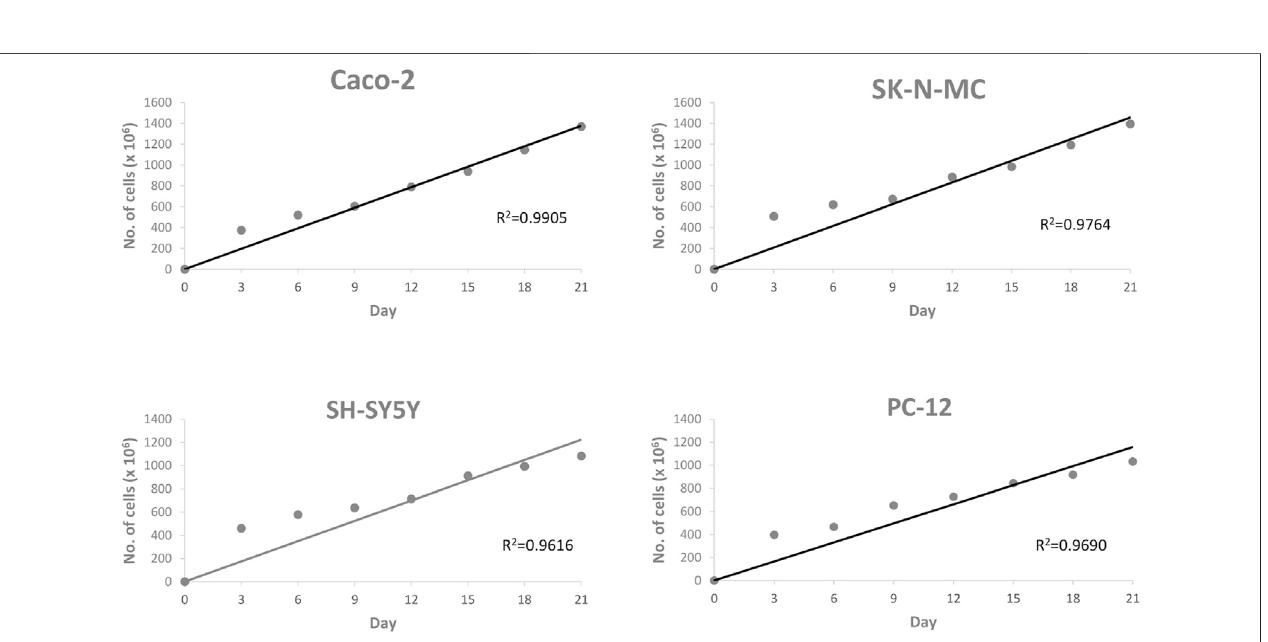
Frontiers in Pharmacology |